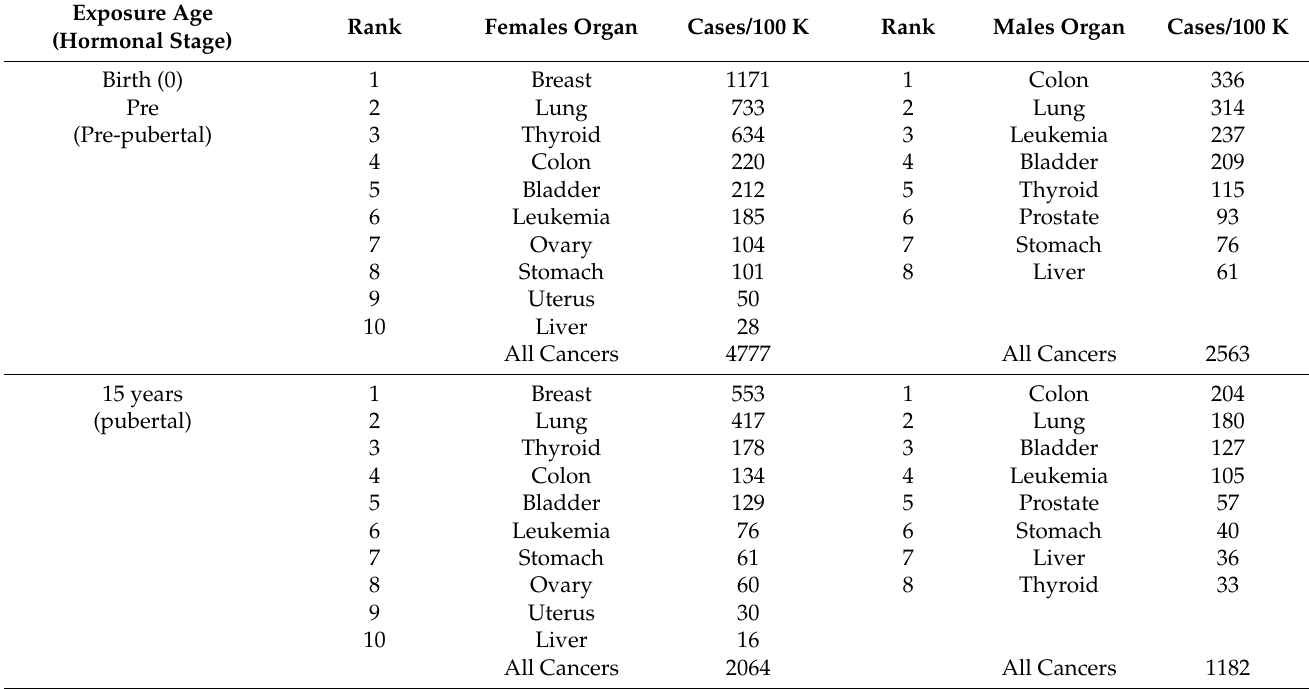
Table 1. Ranking Radiation-Attributable Cancer by Age, Sex and Organ (derived from NCR,